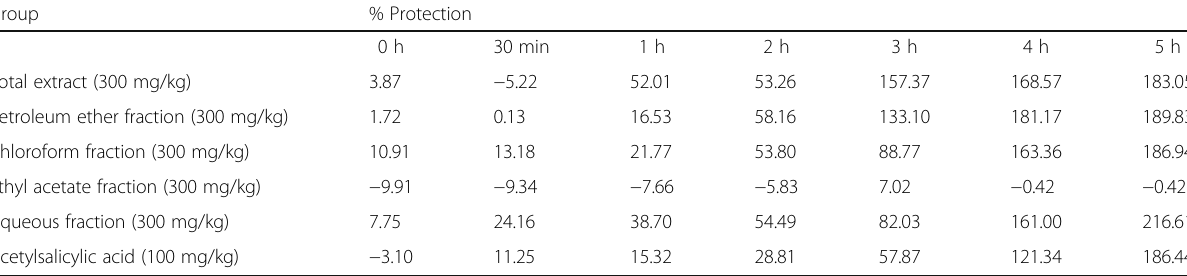
Table 4 Results representing the percentage of protection against thermal stimulus of the total ethanolic extract and different fractions of A. hirtum